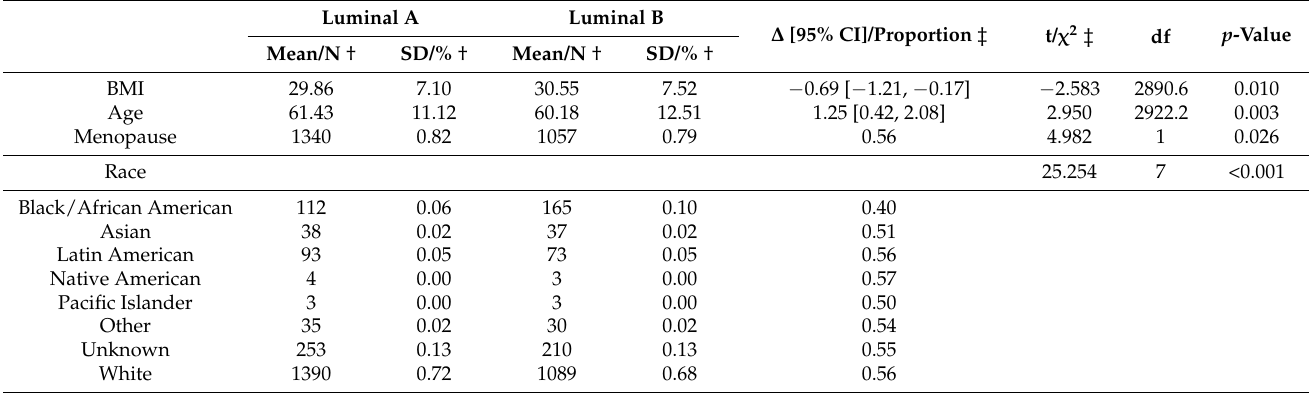
Table 1. Patient characteristics based on breast cancer type.